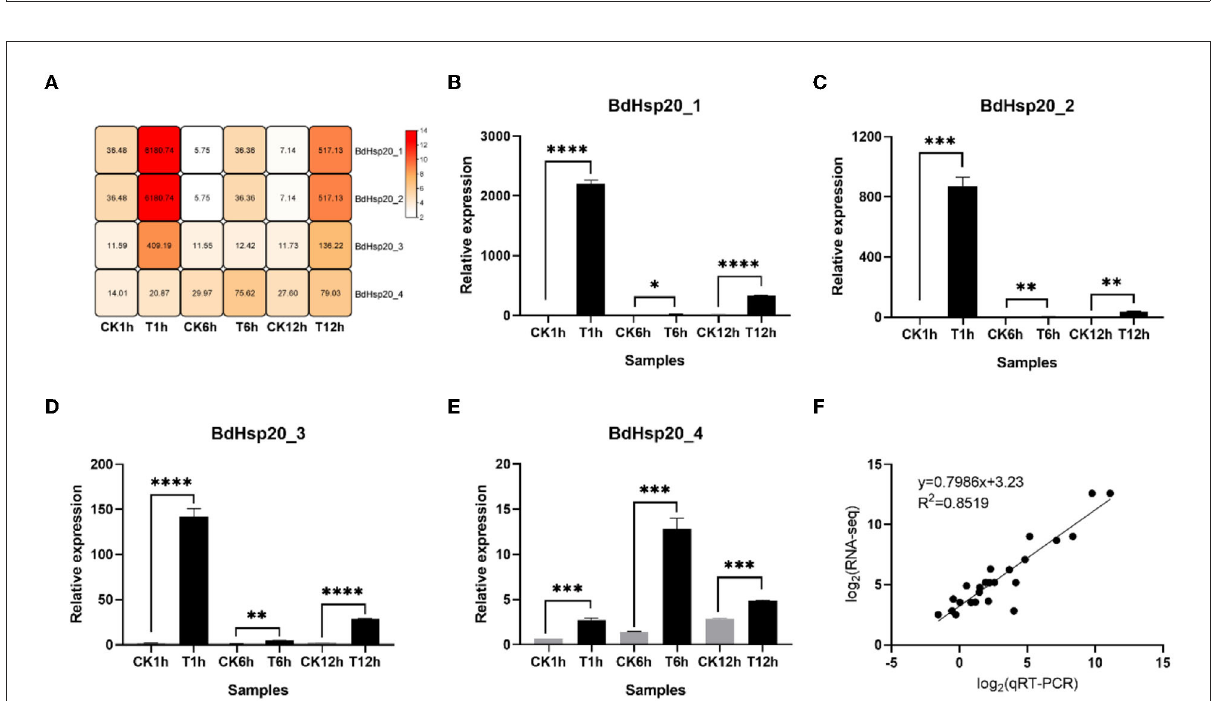
FIGURE7 Heatmap of constructed by FPKM value of BdHsp20 genes assayed by RNA-seq (A) , the relative expression of BdHsp20 genes determined by qRT-PCR (B–E) , and correlation analysis of FPKM value and relative expression of BdHsp20 (F) . * P < 0.05, ** P < 0.01, *** P < 0.001, **** P < 0.0001.